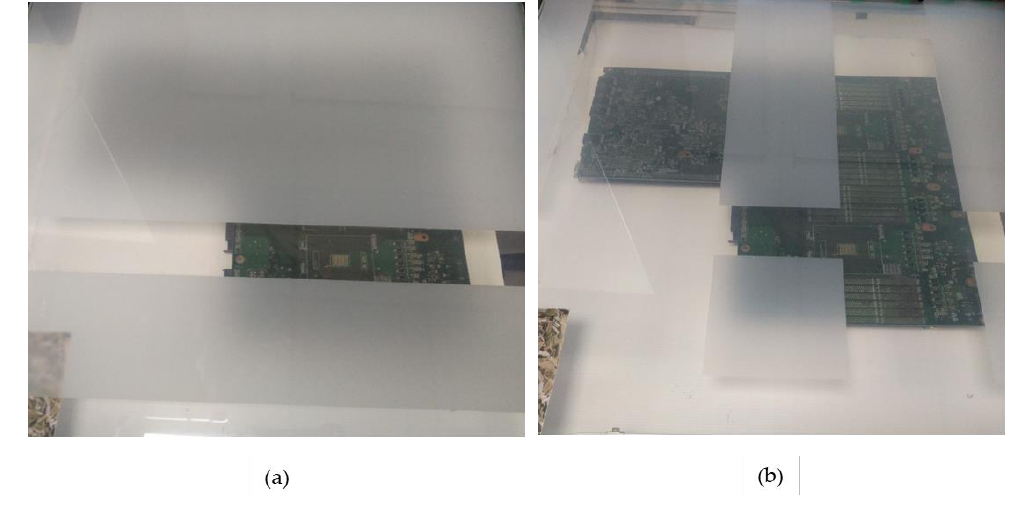
Figure 4. ( a ) Full Occlusion; ( b ) Partial Occlusion.